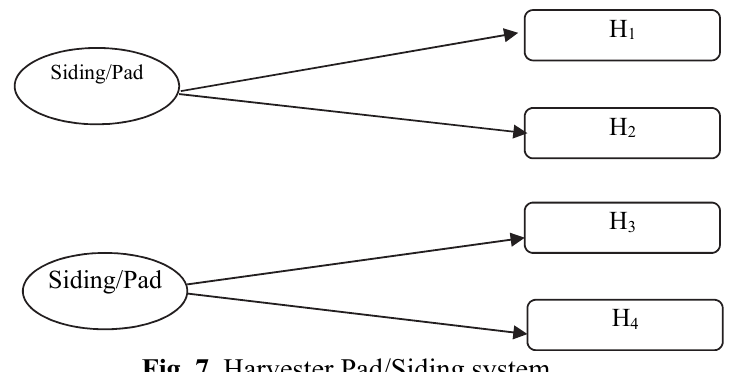
Fig. 7 . Harvester Pad/Siding